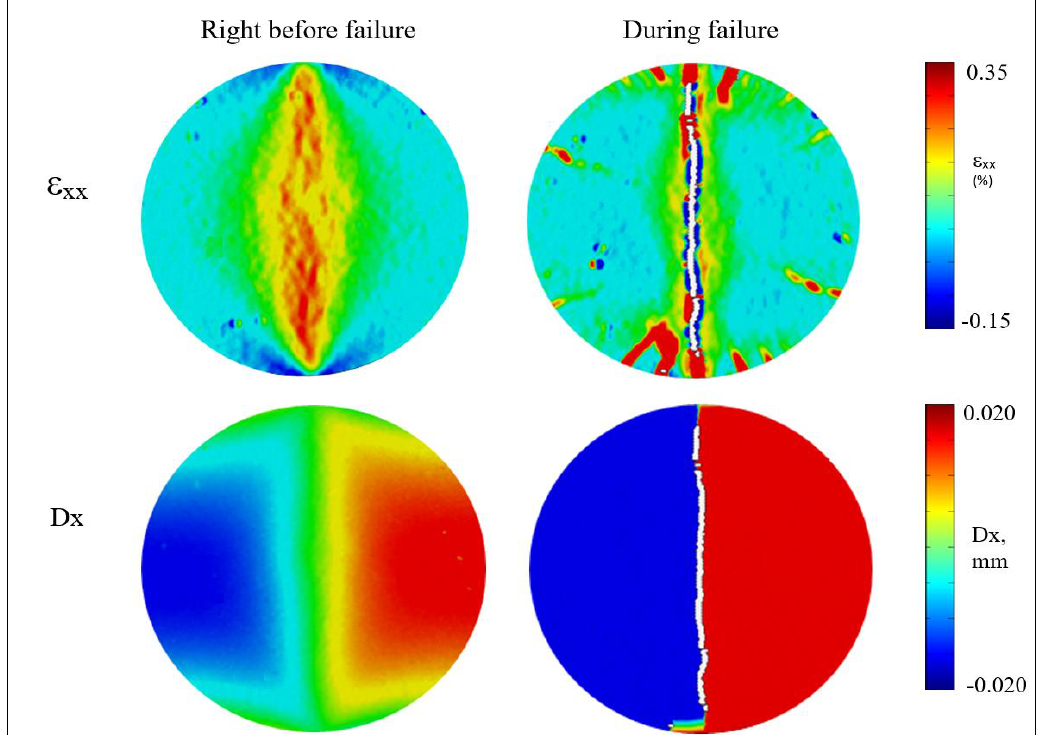
Figure 15. Initiation of cracks in the central region of the sample.